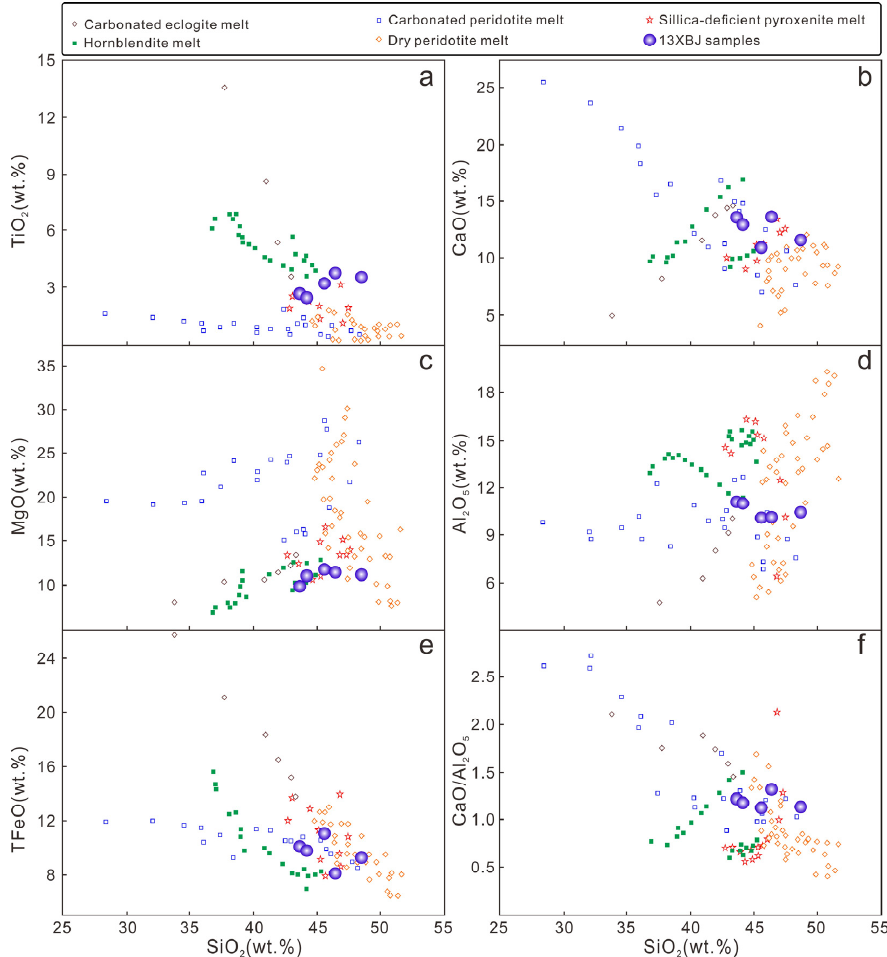
Figure 10. Plots of SiO 2 versus TiO 2 ( a ), CaO ( b ), MgO ( c ), Al 2 O 3 ( d ), TFeO ( e ), and CaO/Al 2 O 3 ( f ) for the 13XBJ samples. Data of different experimental alkali melt compositions are from the works in [128–132].